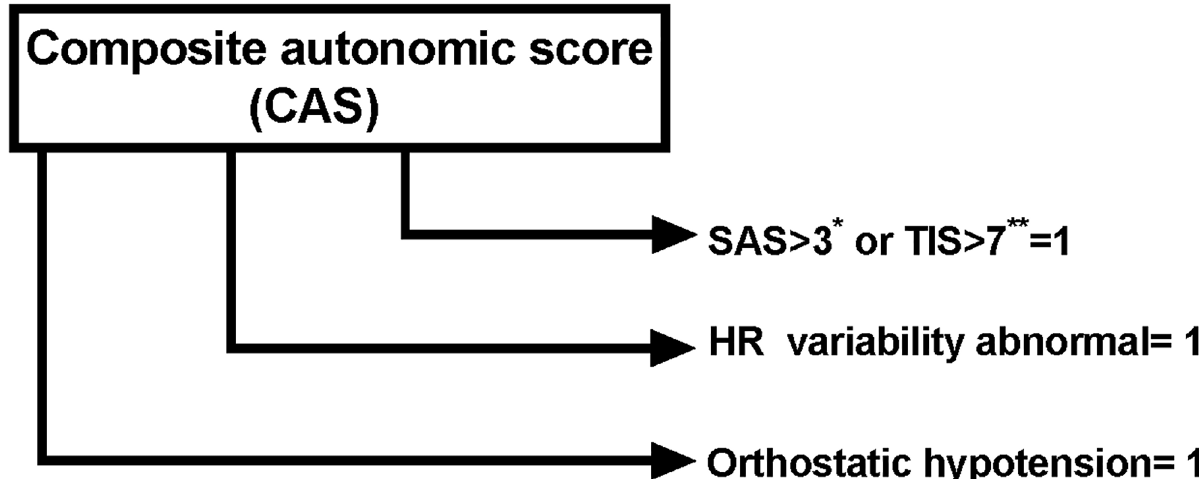
Fig 1. Composite autonomic score. * Survey of autonomic symptoms[27]. ** Total impact score[27].